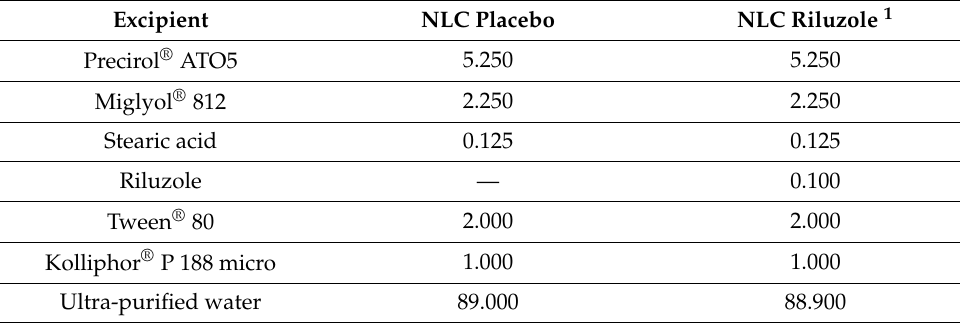
Table 1. Composition of the developed NLC (%, w / w